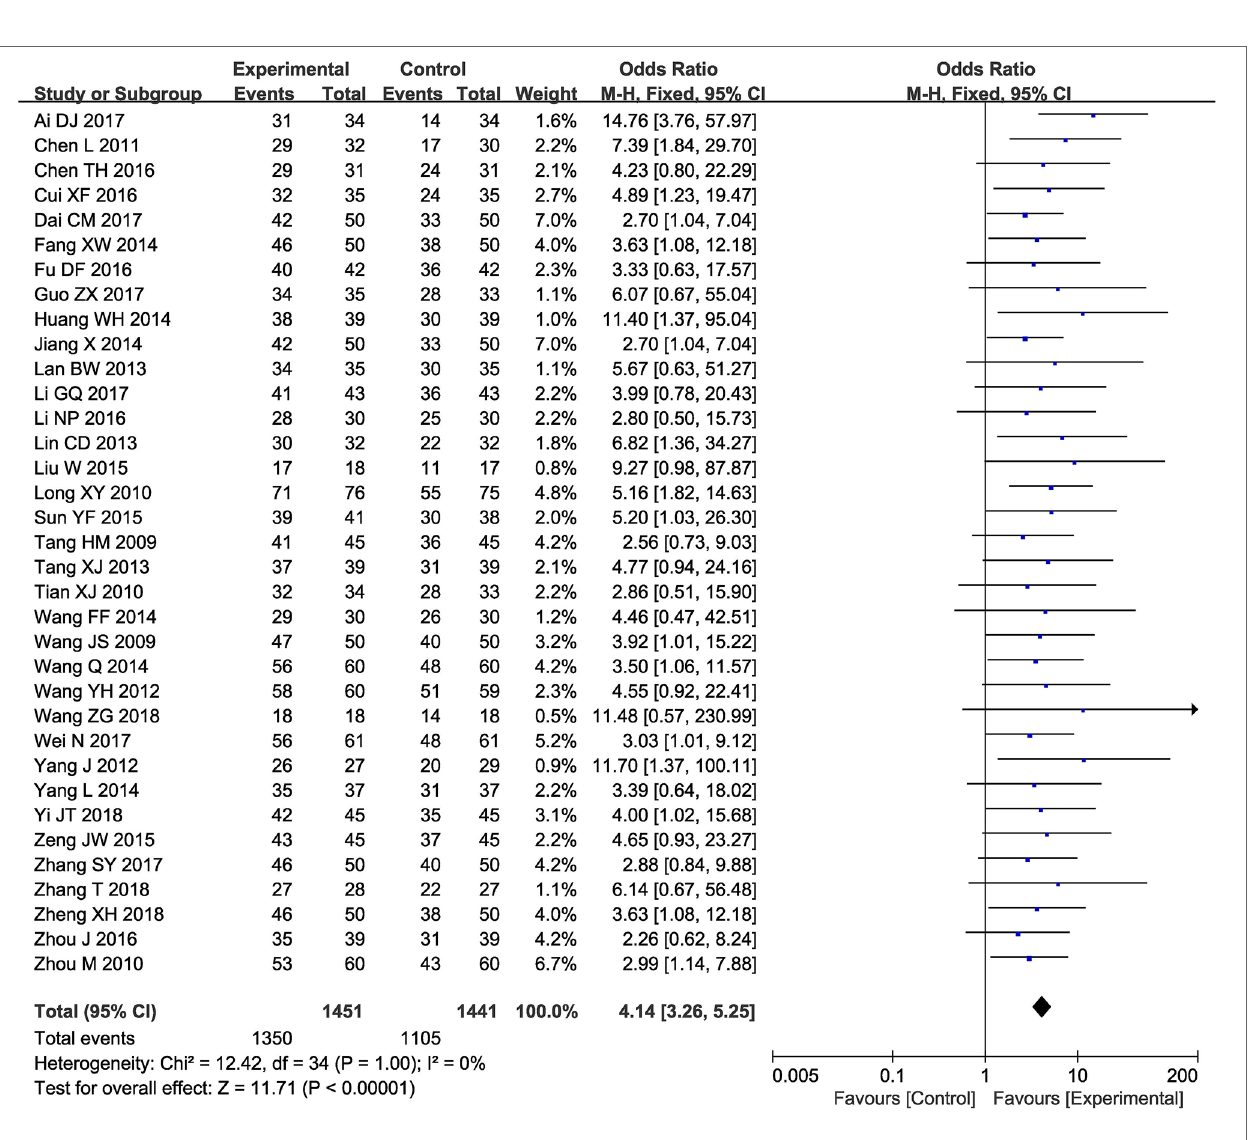
FIGURE 3 | Forest plot of the comparison of overall response rate (ORR) between the experimental and control group. Control group, conventional treatments alone group; Experimental group, conventional treatments and GDI combined group. GDI, Ginkgo leaf extract and dipyridamole injection. The fixed-effects meta-analysis model (Mantel-Haenszel method) was